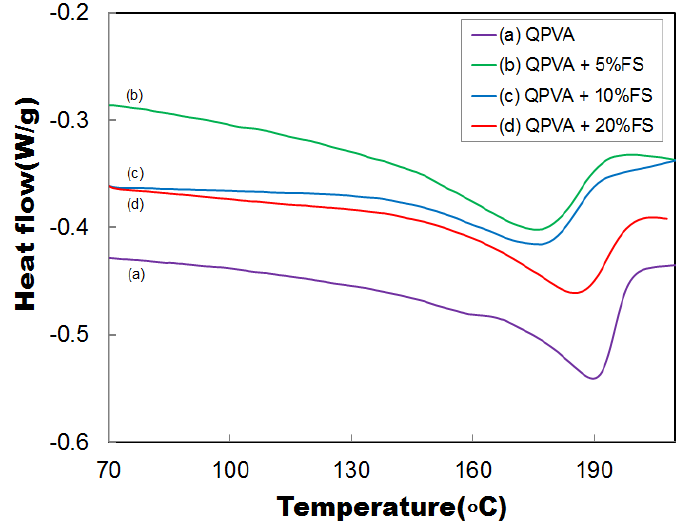
Figure 3. DSC graphs of ( a ) QPVA; ( b ) QPVA/5% FS; ( c ) QPVA/10% FS and ( d ) QPVA/20% FS.